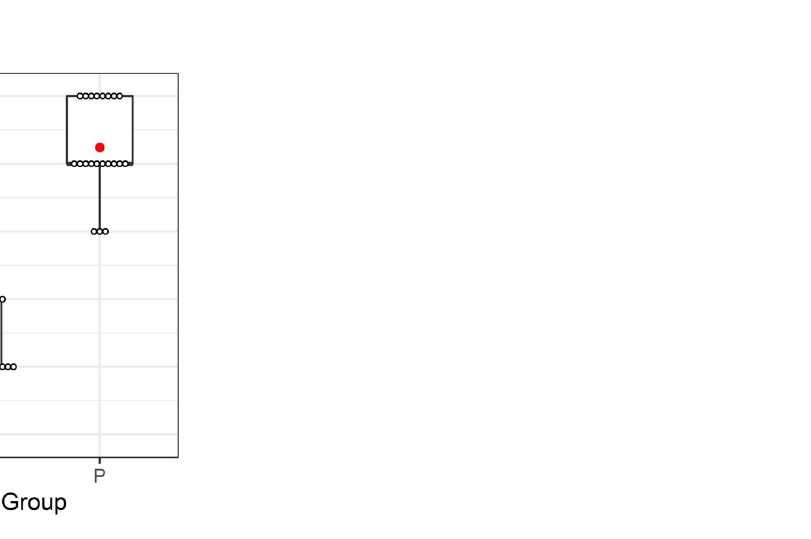
Figure 6. A boxplot representation of length variation of migratory distance (mm) immobilized on a distance- based paper device in an uninfected group (N; n = 33) and infected group (P; n = 21). Lower and upper boundaries of each box indicate the 25th and the 75th percentile, respectively. Ranges are represented as bars (whiskers) below and above the box, and indicate the 10th and 90th percentiles, respectively. Mean values are marked by the red dot marks on the boxplots. Migratory fluorescent distance length values of each sample (2.5 µL loading volume) were represented by white circle marks ( n uninfected = 33 and n infected =